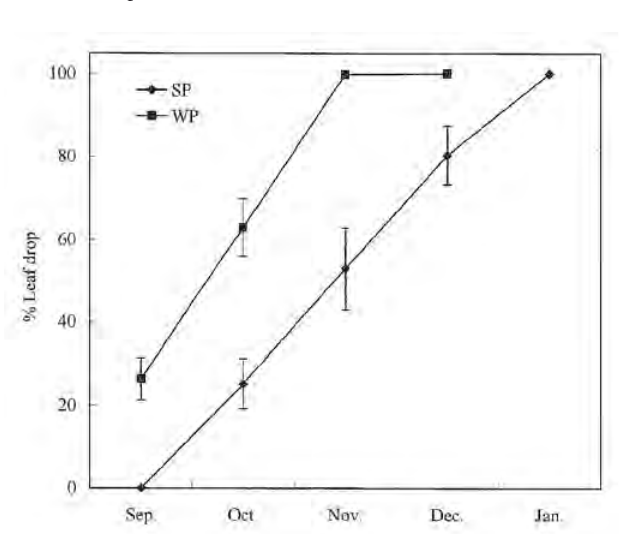
Fig. 11 - Effect of summer pruning on leaf drop in peach trees from September to late January. Data are presented as mean ± stan- dard error ( se